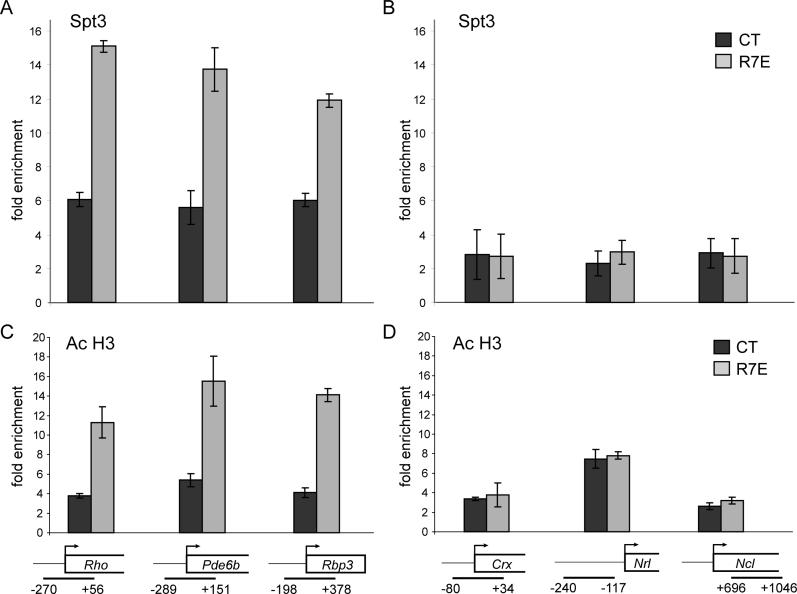
Increased TFTC Recruitment and Histone Acetylation at a Specific Subset of Deregulated Genes in R7E RetinaChIP assays were performed using formaldehyde-fixed chromatin extracts of retina from 2-mo-old control (WT or R7N; dark grey) and R7E (light grey) mice. Primers were selected to amplify promoter or enhancer regions of the specified genes, as depicted.(A and B) ChIPs using an antibody against a TFTC-specific subunit (Spt3) revealed an increased recruitment of Spt3 in R7E retina, at promoters from genes normally highly and specifically expressed in differentiated rods, namelyRho, Pde6b, andRbp3. No such differences could be observed at promoters from two genes regulating rod terminal differentiation,Crx andNrl, and at the intronic enhancer region of a house-keeping gene,Ncl.
(C and D) ChIPs using an antibody against acetylated lysines 9 and 14 of histone H3 (Ac H3) revealed an increased acetylation of histone H3 in R7E retina, specifically at the same promoters, which showed increased Spt3 binding(Rho, Pde6b, andRbp3). Promoters fromCrx, Nrl, andNcl did not show any differences in histone H3 acetylation.The amount of immunoprecipitated DNA was quantified by real-time PCR and normalized to the amount of DNA present in a fraction of the input chromatin extract. Values are expressed as fold enrichment over background IP signals obtained in corresponding no antibody ChIP experiments (seeFigure S9). Each bar represents the mean value ± SEM (n = 4).